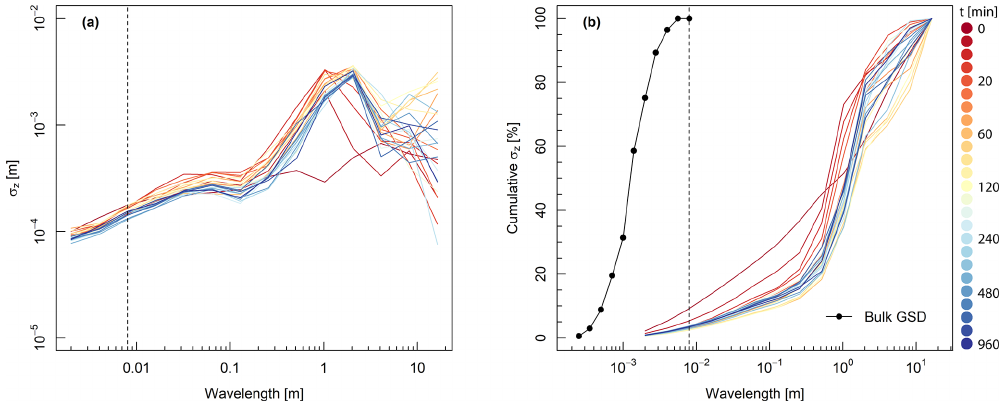
Figure 6. Form size distribution during Experiment 1a, where each line represents a point in time and the initial screeded bed is included. The standard deviation of each topographic wavelength is presented as an (a) absolute and (b) cumulative percentage, for each thalweg elevation profile. The bulk grain size distribution is included, where the wavelength corresponds to grain diameter. The vertical dashed line represents the largest grain diameter in the experiment.